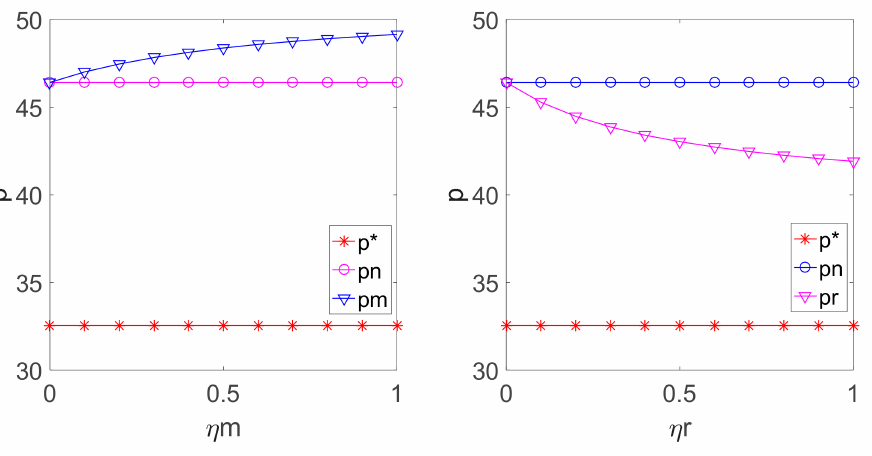
Figure 4. Relationship among η m , η r and p